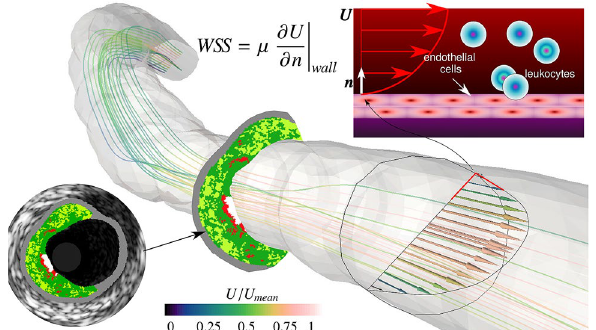
Figure 1. Schematic of the blood hemodynamics and leukocyte adhesion process. The wall shear stress ( WSS ) is the (tangential) force which blood flow applies on the artery wall and depends on the fluid viscosity µ and the shear rate ( ∂ U /∂ n where n is the normal to the arterial wall). If the WSS is large, blood will wash away leukocytes from the endothelium and impede adhesion, whereas in presence of low WSS chance of adhesion is greater. After adhesion, leukocytes transmigrate inside the arterial wall increasing the plaque area (red, green and white regions in the intravascular ultrasound image). U mean = 0.384 m / s is the mean bulk velocity throughout the cardiac